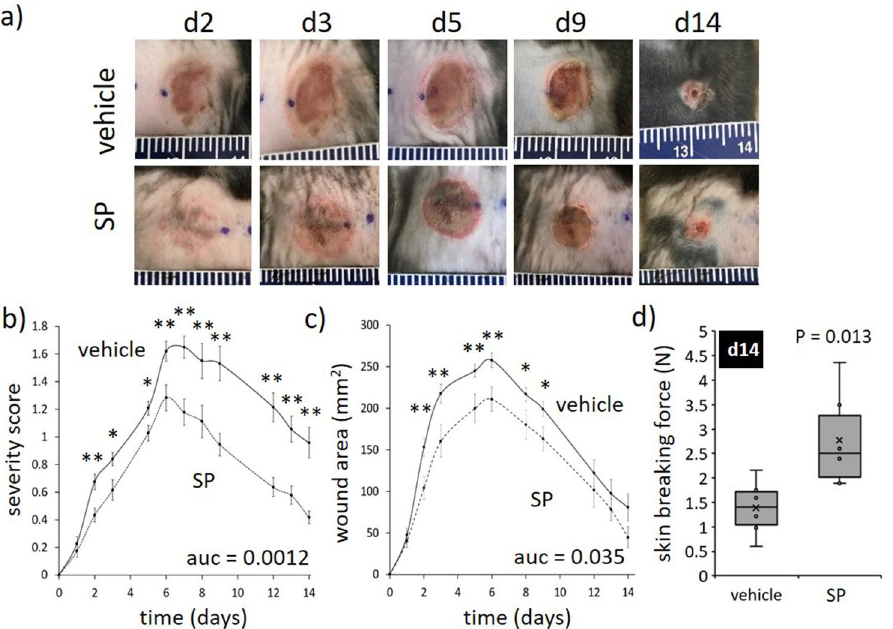
Figure 2. SP reduces I/R-mediated pressure injury severity. ( a ) Representative pressure injury photos. ( b ) Pressure injury severity score. ( c ) Macroscopic measure of wound area. Data in ( b , c ) displayed as SP-treated (dashed line) and vehicle-treated (solid line) and presented as mean ± SEM at each time point, n = 6. Auc = area under the curve. ( d ) Minimum wound breaking force at d14 post-injury, n = 6 wounds per group. Data presented as box and whisker plot. * P < 0.05, ** P < 0.005. Data analyzed by two-way ANOVA with Bonferonni post-hoc